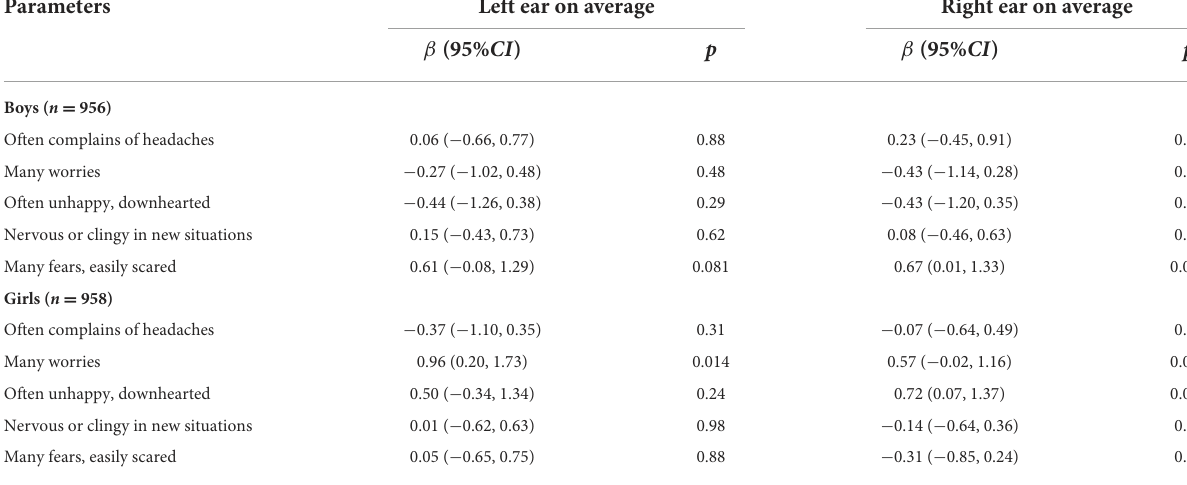
TABLE 4 The association of emotional symptoms with hearing thresholds among 1,914 children aged 6–8 years in Beijing, China. Parameters Left ear on average Right ear on